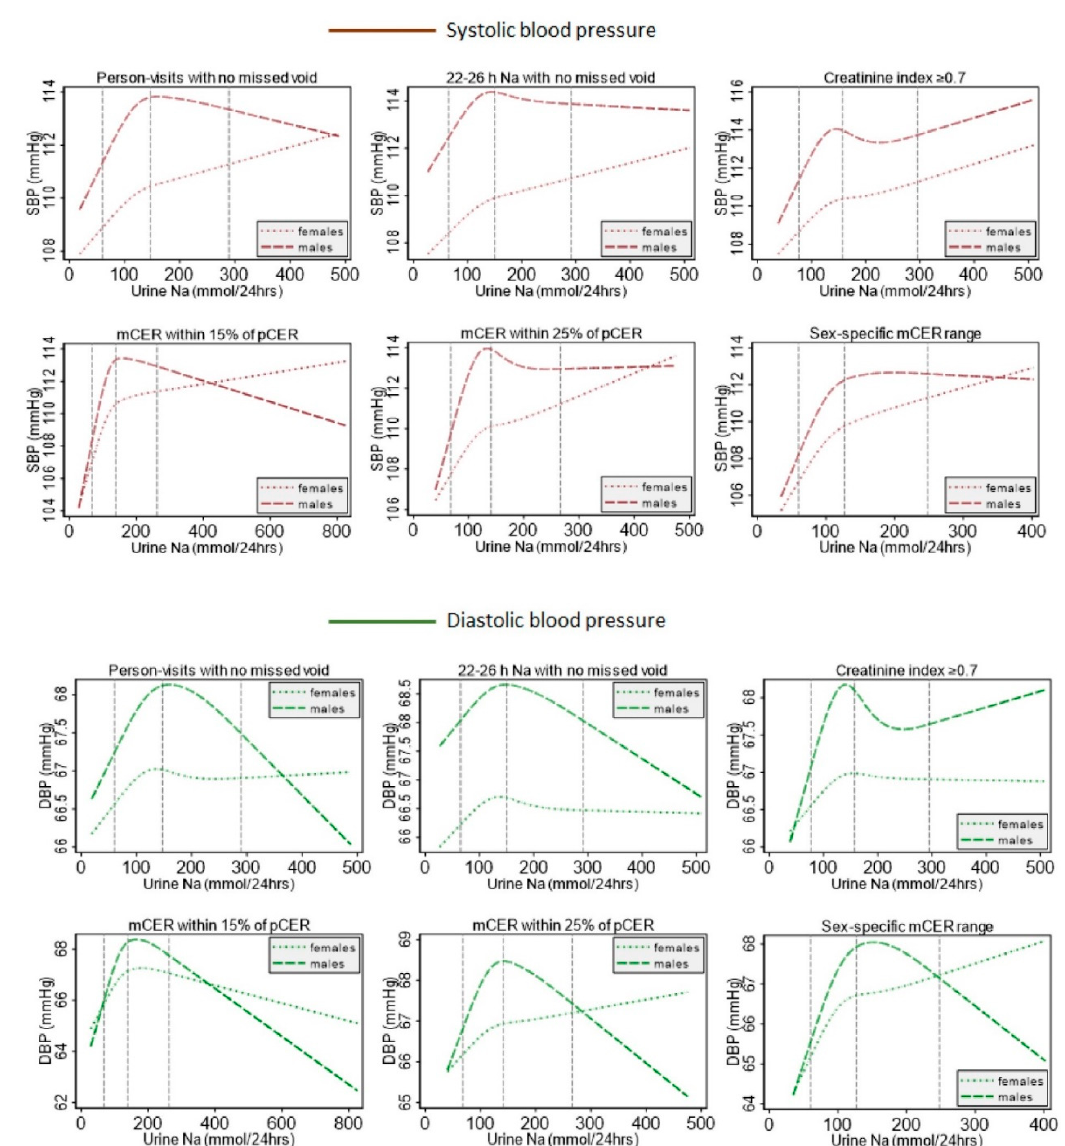
Figure 3. Restricted cubic spline plots of the sex-specific relationship between urinary sodium and blood pressure from different methods of evaluating the completeness of 24-h urine collection. Models were adjusted for age, sex, BMI, smoking status, physical activity, sleep, alcohol consumption, religion, and household wealth. Vertical dotted blue dotted lines indicate the 5th, 50th, and 95th percentile distribution of urine sodium excretion. mCER: measured 24-h urine creatinine excretion; pCER: predicted 24-h urine creatinine excretion.